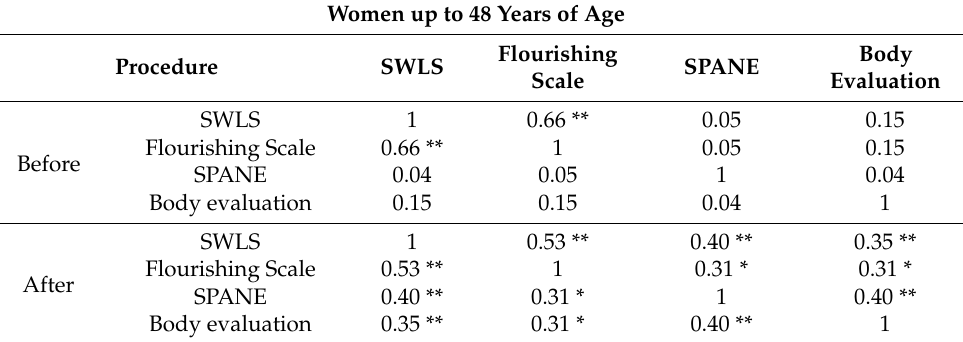
Table 7. Correlations of various forms of well-being and body self-esteem in patients up to 48 years of